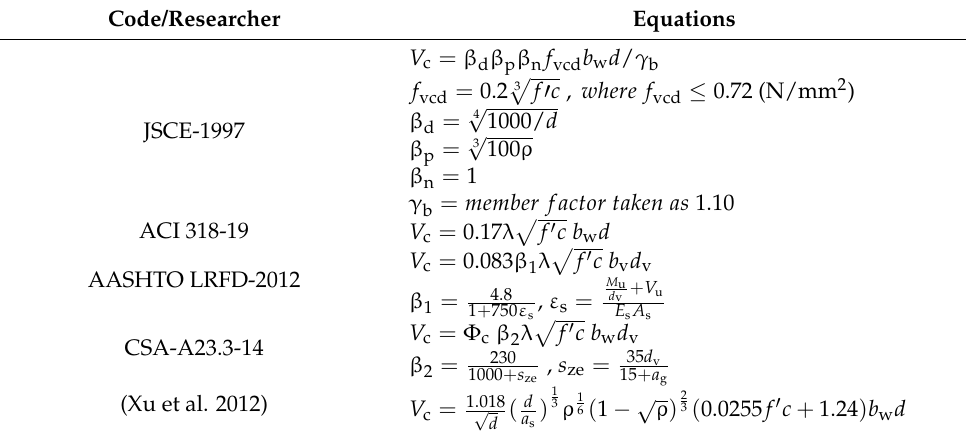
Table 1. Summary of code provisions and simplified shear design